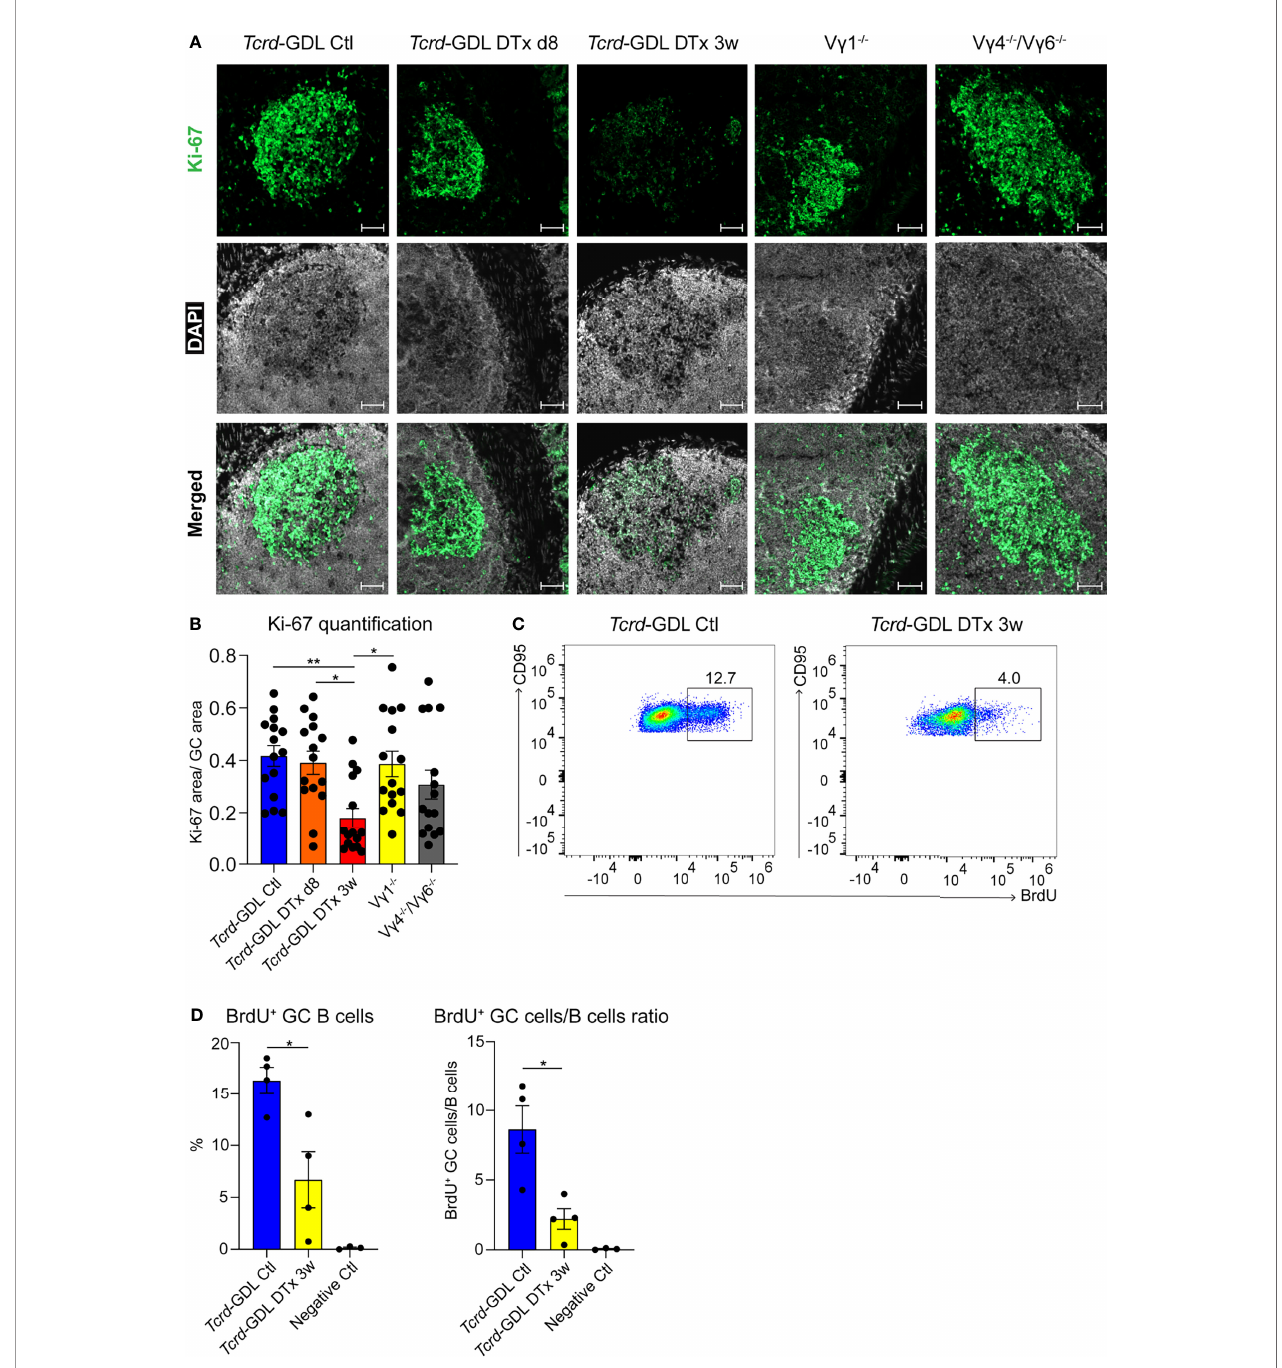
FIGURE 5 | Decreased proliferation in the DZ of GCs after gd T cell depletion. (A) Fluorescence microscopy of frozen sections of PPs from non-depleted and gd T cell – depleted (8 days and 3 weeks) Tcrd -GDL, V g 1 − / − , and V g 4 − / − /V g 6 − / − mice stained with anti-Ki-67 (green) and DAPI (white) to detect the nuclei. Scale bar, 50 µm. All sections were handled and treated similarly, and all pictures were acquired using the same settings. (B) For the quanti fi cation, sections from the proximal, medial, and distal part of the PPs were analyzed for each mouse. Each dot represents an individual cut. Bar graph, mean ± SEM. n = 5 mice per group. ANOVA test was applied with Tukey post-hoc test. (C, D) Non-depleted and 3-week gd T cell – depleted Tcrd -GDL mice were injected with bromodeoxyuridine (BrdU) and analyzed 2 h after injection. (C) FACS analysis of BrdU + GC B cells gated on GC B cells (CD19 + , CD138 − , GL7 + , CD95 + ) from PPs. (D) Quanti fi cation of BrdU + GC B cells (CD19 + , CD138 − , GL7 + , CD95 + , BrdU + ). Bar graphs, mean ± SEM. n = 4 mice per group. T-test was applied. Each dot represents an individual mouse. *P < 0.05, **P <